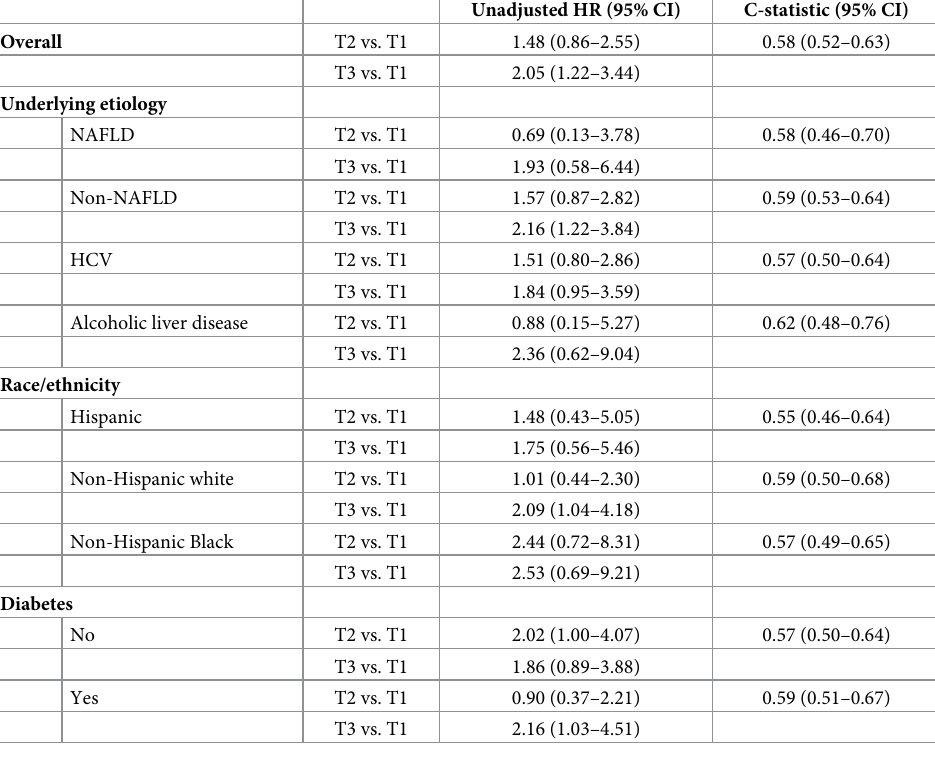
Table 2. Association between the polygenic risk score and risk of HCC in cirrhosis patients overall and by under- lying etiology and